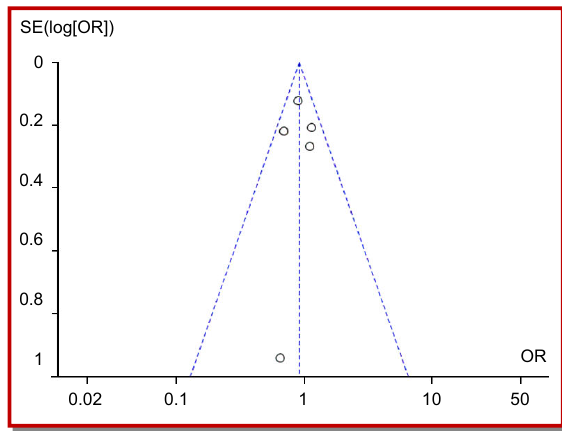
Figure 3: Funnel plot of risk of recurrent venous thromboembo- lism between NOACs and vitamin K